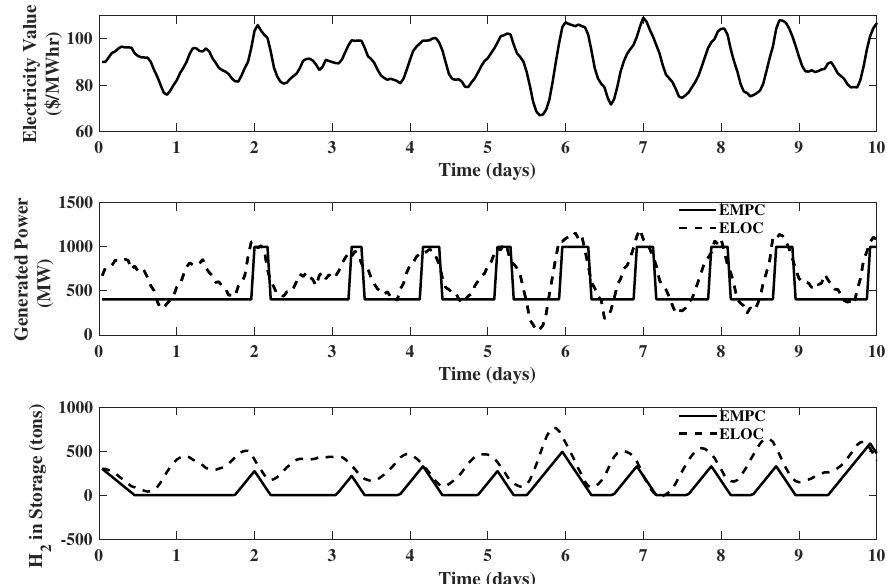
Figure 11. Comparison of EMPC and Economic Linear Optimal Control (ELOC) policy for Example 9: generated power and hydrogen storage.